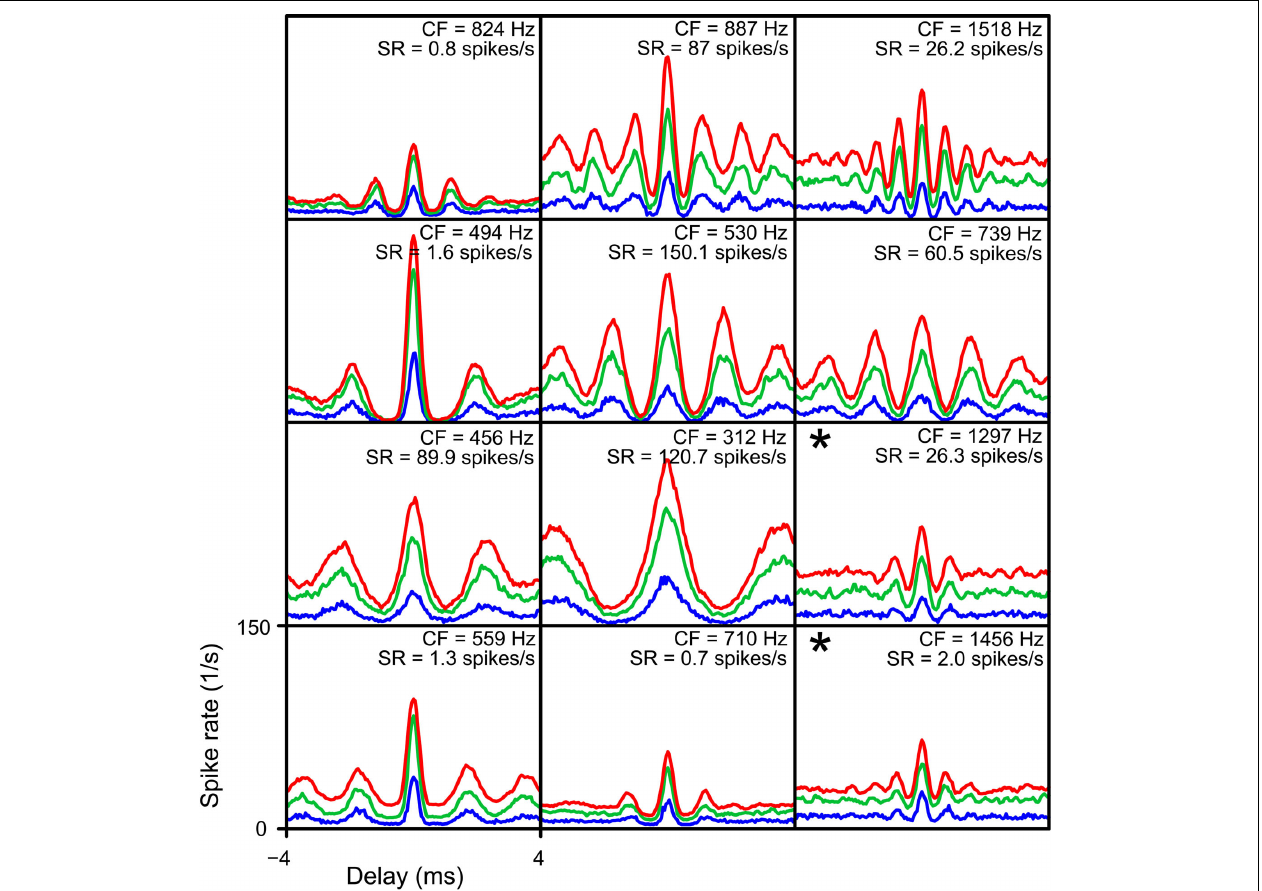
FIGURE 13 | Simulated NDFs for TB datasets, for different values of cw . In every panel NDFs are shown for one TB dataset, for cw = 50 μ s (blue), cw = 150 μ s (green) and cw = 250 μ s (red). CF and SR are indicated for each dataset. Range of abscissa and ordinate indicated in lower left panel apply to